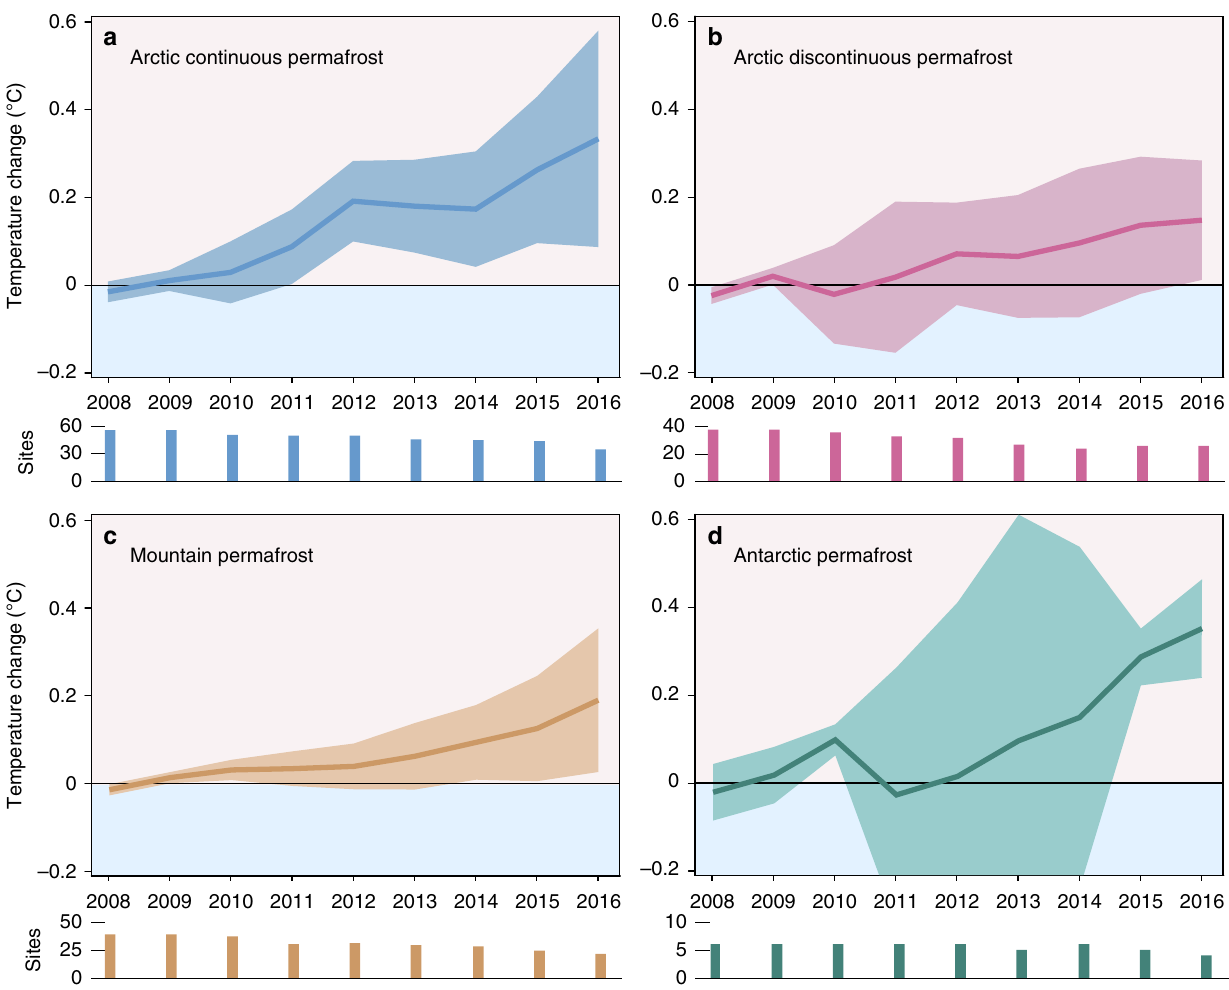
Fig. 3 Annual permafrost temperature change. a – d Permafrost temperature departure Δ (cid:1) T y ; b calculated from mean annual ground temperatures in boreholes near the depth of zero annual amplitude Z * relative to the 2008 – 2009 reference period. Mean values calculated as de-clustered, indexed area- weighted averages (Eq. 1). Temperature uncertainties are expressed at 95% con fi dence. Sample size shown is the number of borehole sites per year